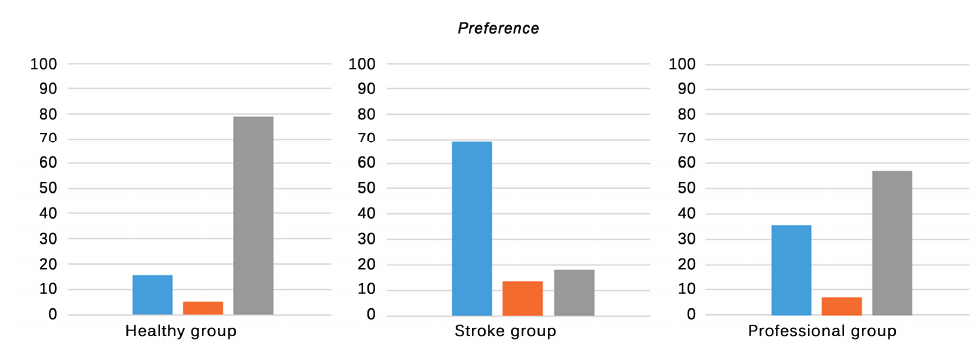
Figure 7. Subjective responses of all groups regarding their order of preference. Blue : NaturalPoint ® OptiTrack TM ; Orange : Polhemus TM G4 TM ; Grey : Microsoft ® Kinect TM . Only significant differences are stated. * p < 0.05, ** p <